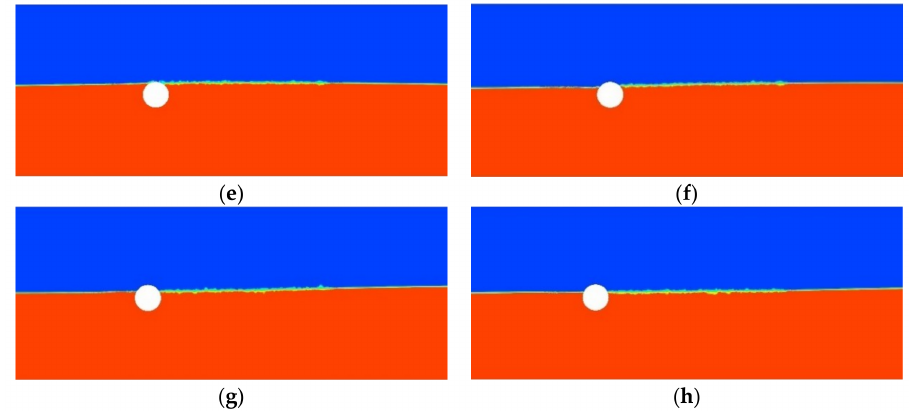
Figure 25. Snapshot of the evolution process of a solitary wave interacting with the moving cylinder U c = 0.1 m / s for model 2. ( a ) t = 17 s, ( b ) t = 17.5 s, ( c ) t = 18 s, ( d ) t = 18.5 s, ( e ) t = 19 s, ( f ) t = 19.5 s, ( g ) t = 20 s, ( h ) t = 20.5 s.